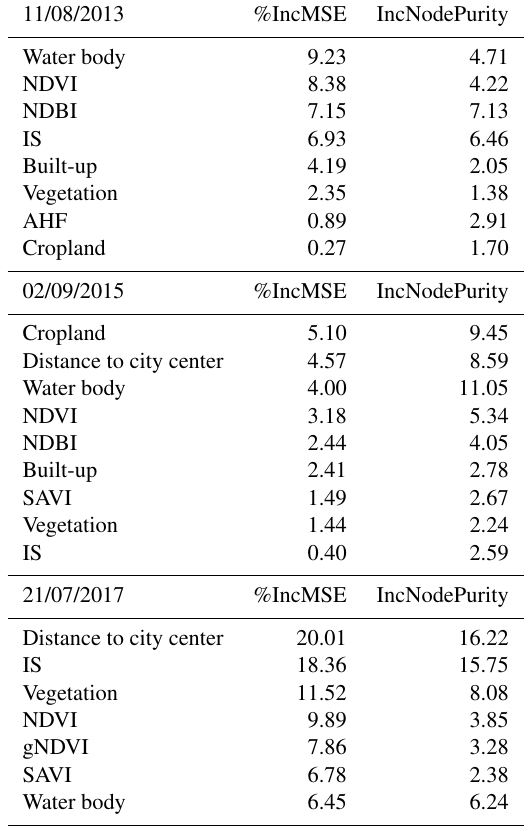
Table 3. R 2 and RMSE of stepwise regression, GWR (geographi- cally weighted regression), and the RF model within a 2km buffer zone. Date format: dd/mm/yyyy.